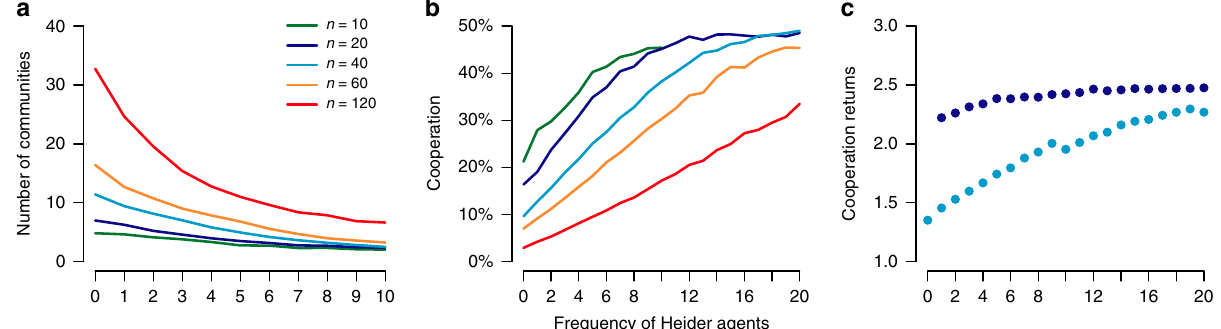
Fig. 2 Heider agents increase cooperation, group welfare, and group polarization. a The average number of communities decreases (measured by the Louvain method for community detection 34 ). Hence, the population becomes more polarized, as the number of Heider agents increases, across different population sizes (green line: n = 10, dark blue line: n = 20, light blue line: n = 40, yellow line: n = 60, red line: n = 120). b Meanwhile, cooperation rates increase with increasing numbers of Heider agents, and c friend-focused agents (light blue dots) bene fi t from Heider agents (dark blue dots), as their average welfare increases